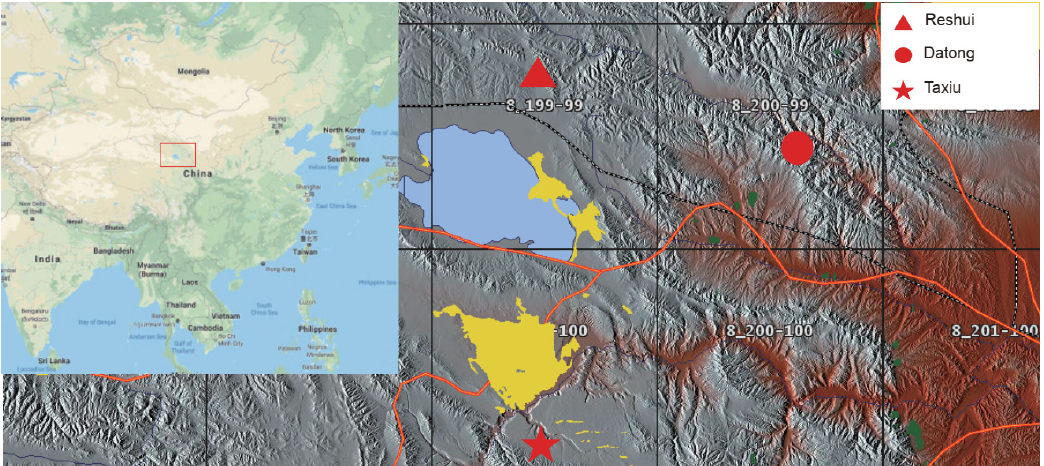
Figure 1. Map for fecal sample collection sites. Triangle denotes the sympatric plateau pika and yak collection sites. Circle denotes locations where allopatric yak’s fecal samples were collected. Pentagram denotes locations where allopatric plateau pika’s fecal samples were collected. The map of China comes from Google earth, and the map of Qinghai Province comes from an open-source website (https://maps-for-free.com/ (accessed on 8 February 2021)).